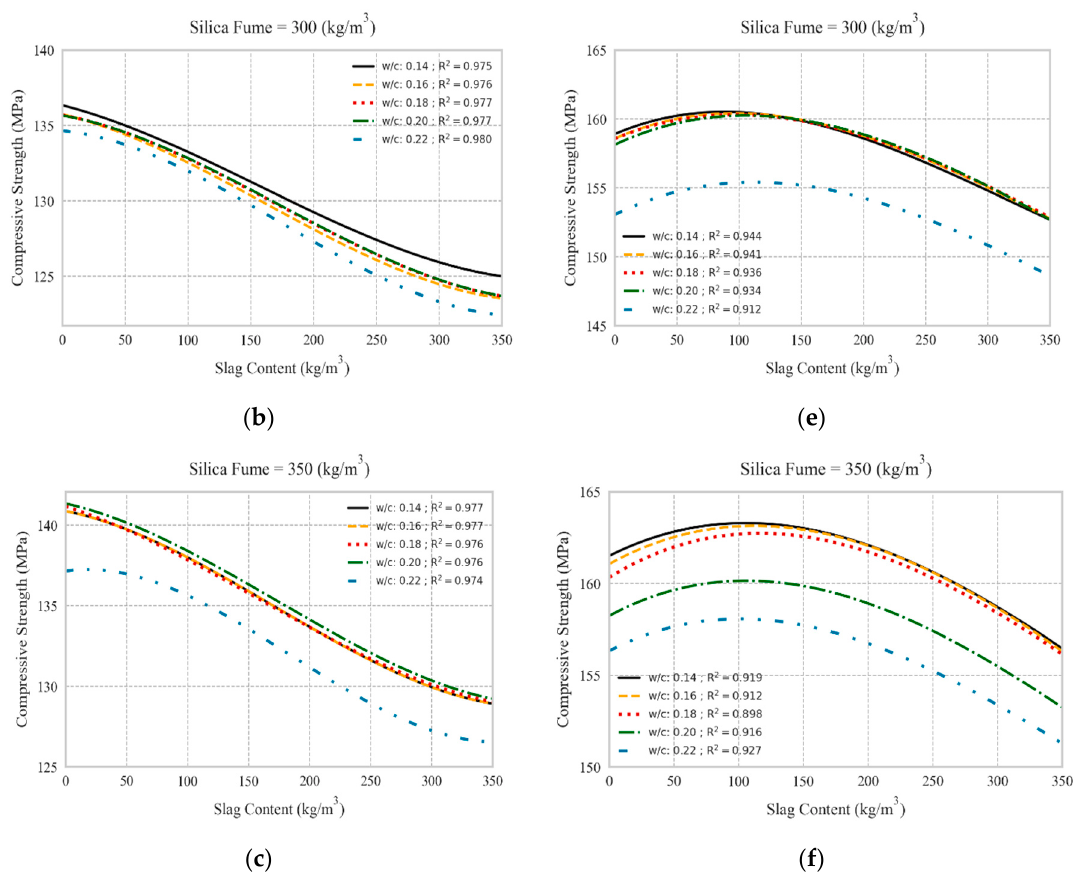
Figure 7. Effect of slag partial replacement for cement on compressive strength: ( a – c ): without steel fiber having 250, 300, and 350 kg/m 3 silica fume, respectively; ( d – f ): with 2% vol. steel fibers having 250, 300, and 350 kg/m 3 silica fume, respectively.